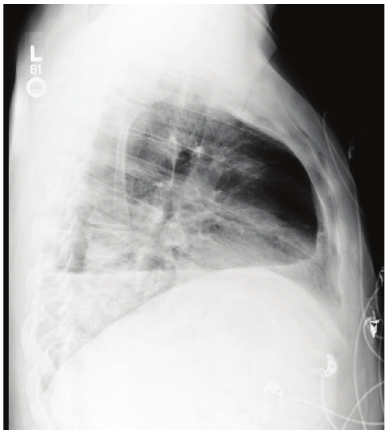
Figure 3: Chest X-ray on representation demonstrating pyopneu-